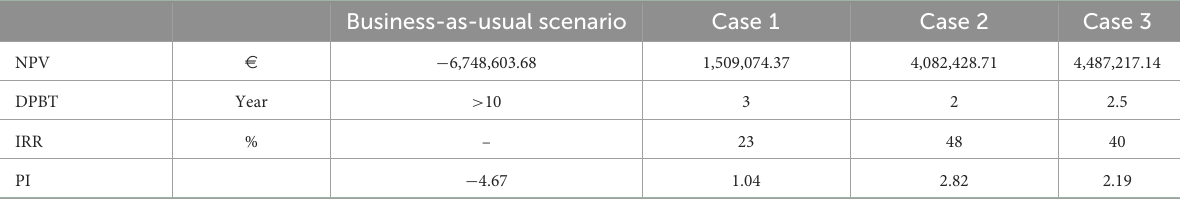
TABLE 4 Profitability analysis for the 4 hypothetic